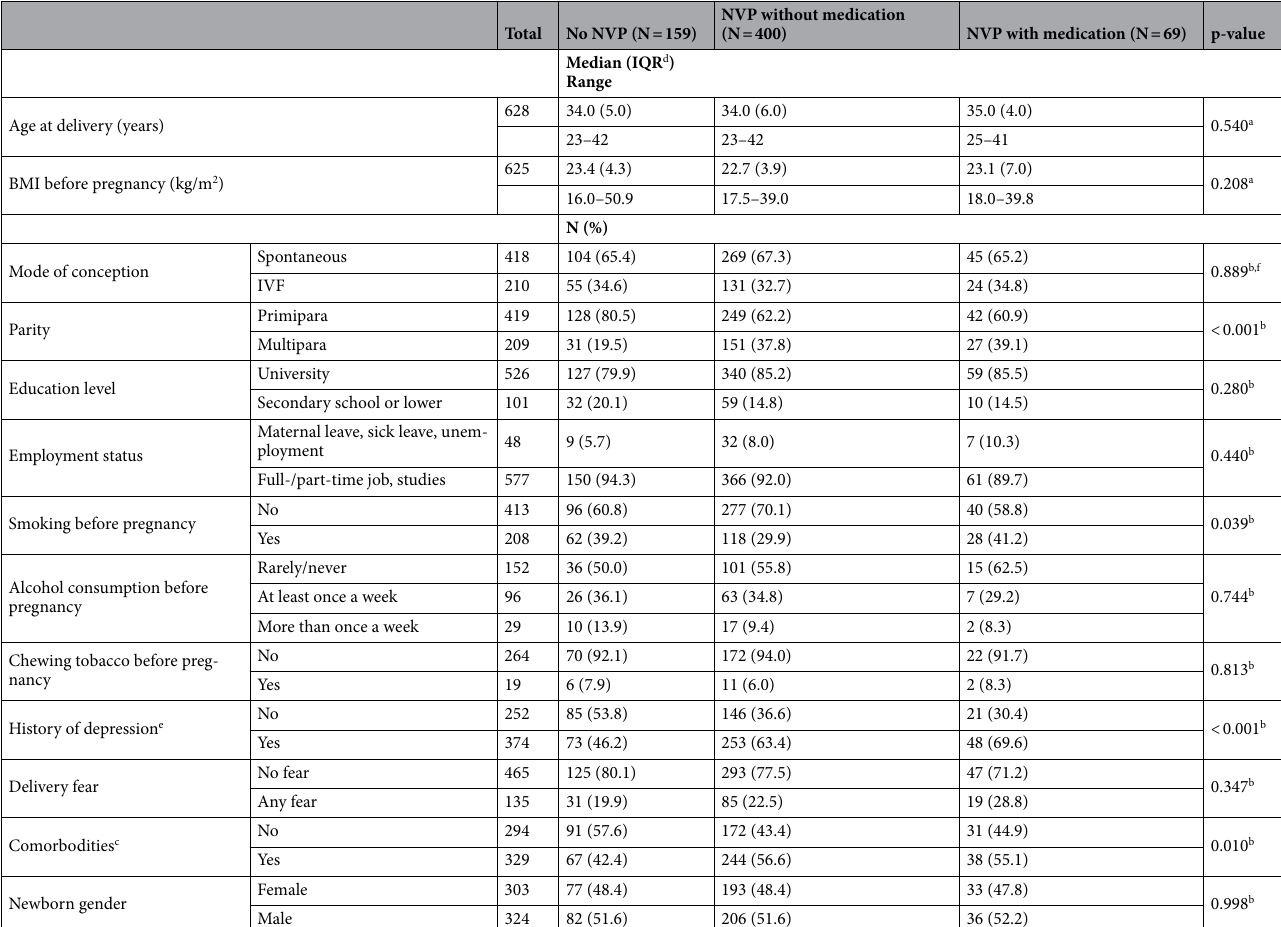
Table 2. Sociodemographic and pregnancy-related characteristics of study sample by nausea group. a